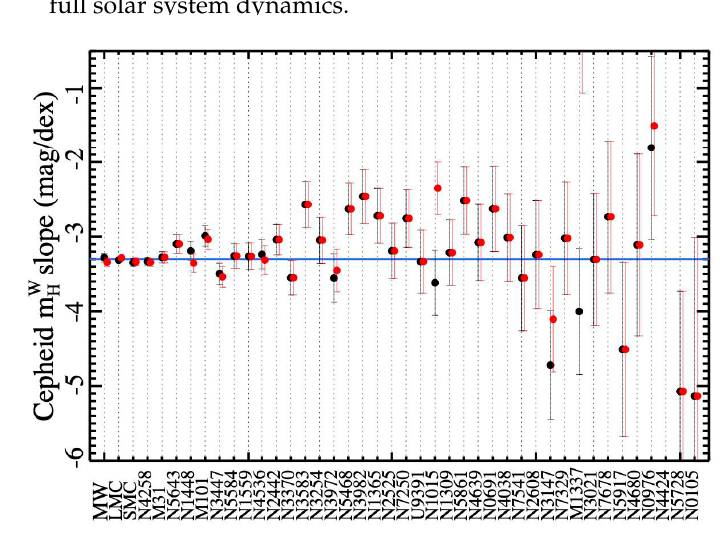
Figure 7. The period-luminosity parameter for the Cepheids in anchor galaxies and in SnIa host galaxies (Figure 10 from Ref. [2]). The trend for most SnIa hosts (more distant galaxies) for a higher value of the Cepheid period-luminosity parameter ( m W slope) compared to nearby galaxies (MW, H LMC, SMC, N4258 and M31) is evident. This trend is even stronger if the outliers are also included in the sample (red